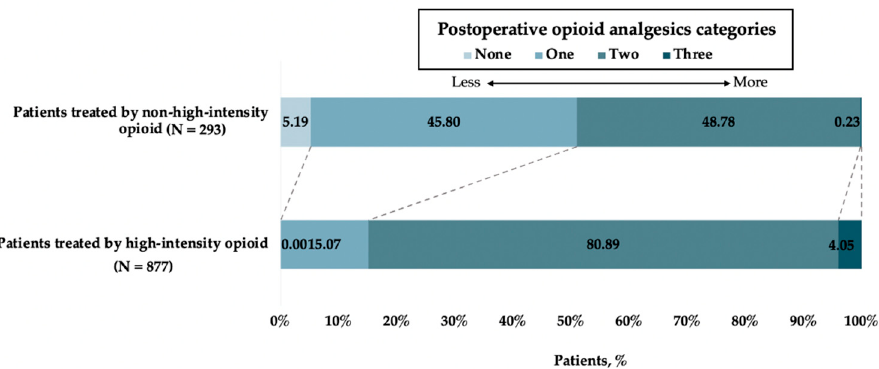
Figure A2. Frequency of patients in the high-intensity ( n = 239) or low-intensity ( n = 877) groups who were treated with single or multiple opioids.